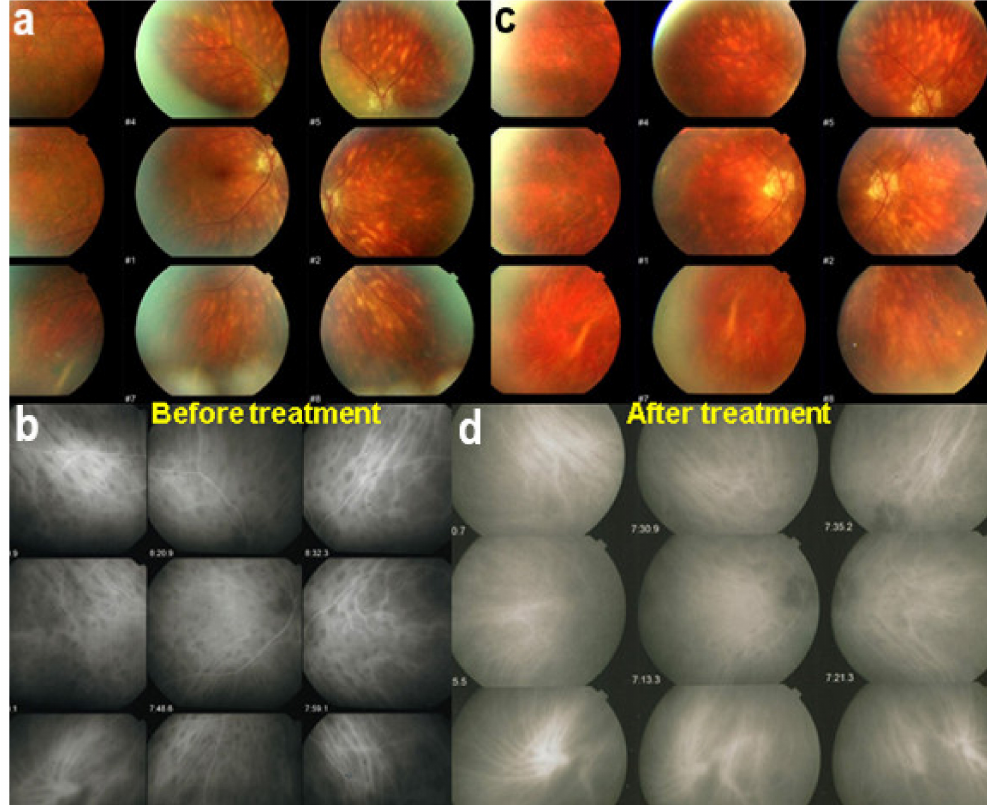
Figure 46. ICGA lesions. Fundus examination is best to monitor disease activity (right eye). This patient accepted treatment with delay with numerous hypopigmented birdshot lesions. After applying immunosuppressive therapy, the HDDs, numerous before treatment ( b ) responded to treatment ( d ), while no fundus change was seen ( a , c ), as birdshot fundus lesions correspond to stromal